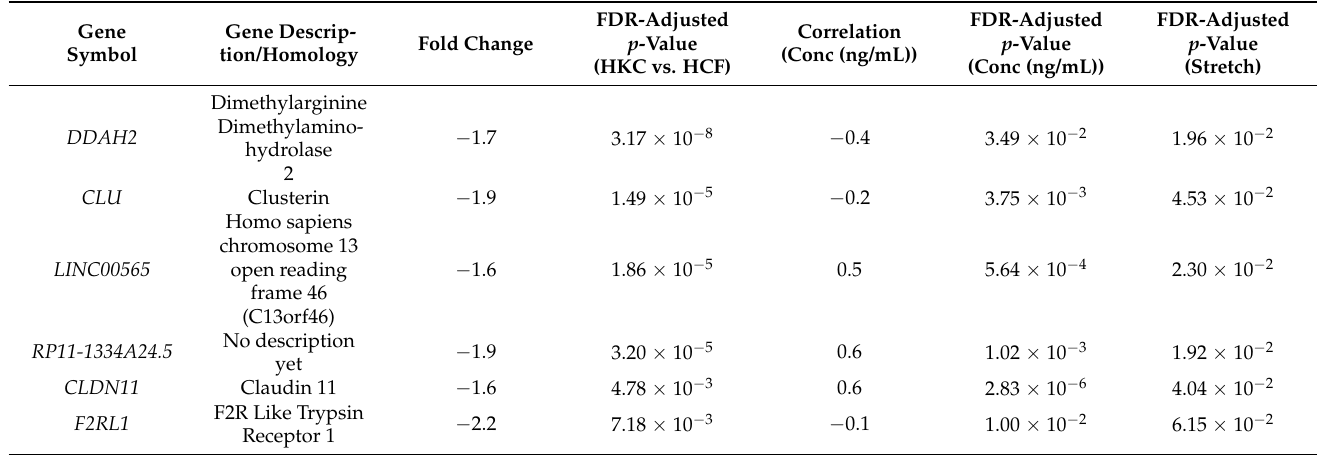
Table 5. KC-altered genes responsive to TGF β 1 treatment and